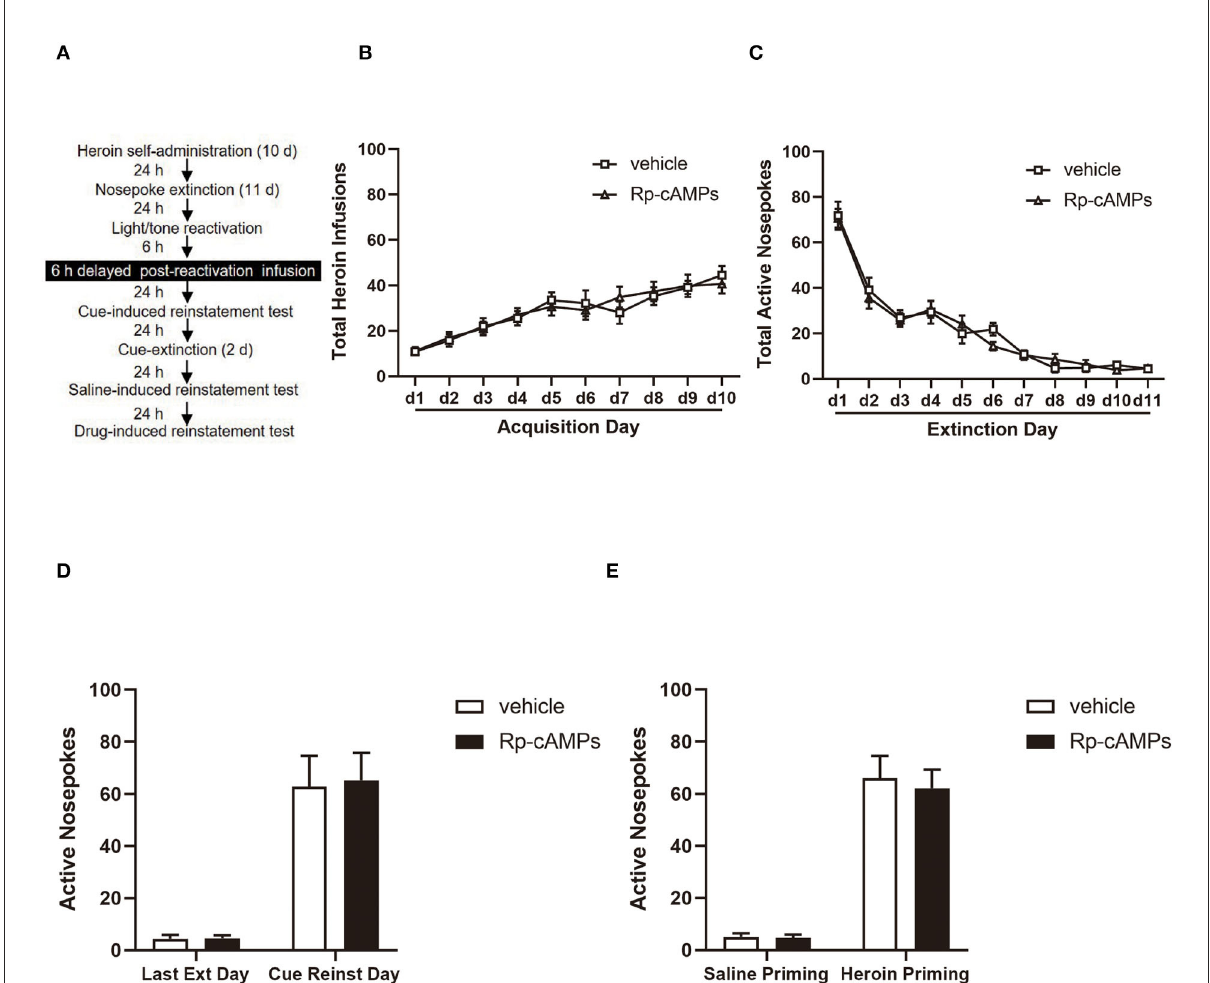
FIGURE4 The effect of delayed reactivation of intra-BLA PKA inhibition on the subsequent cue- and heroin-induced reinstatement tests. (A) Timeline of the experimental procedure. (B) The total number of infusions during acquisition of heroin self-administration. (C) The total number of active nosepoke responses during extinction sessions. (D) Active nosepoke responses during the last day of extinction and the cue-induced reinstatement test. (E) Active nosepoke responses during the saline- or heroin-primed reinstatement tests. The value of n = 8 rats per group. Data are means ± SEM. Ext, extinction; Reinst,